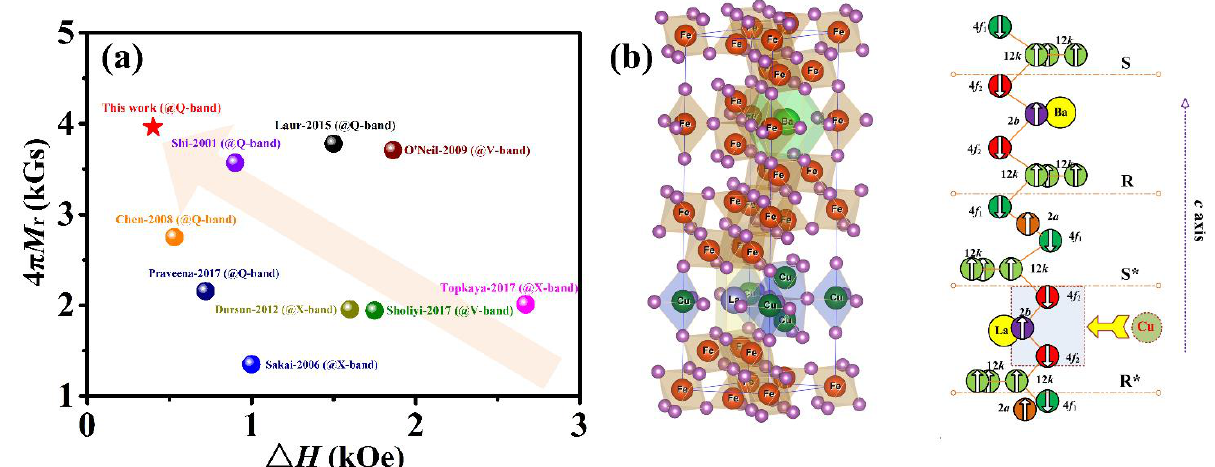
Figure 1. ( a ) Published values for 4 π M r and ∆ H FMR for bulk barium hexaferrite compositions relevant to the present work. The upper left quadrant is the region representing ideal properties. ( b ) Atomic unit cell with spin distribution for the La-Cu substituted barium hexaferrites studied here.